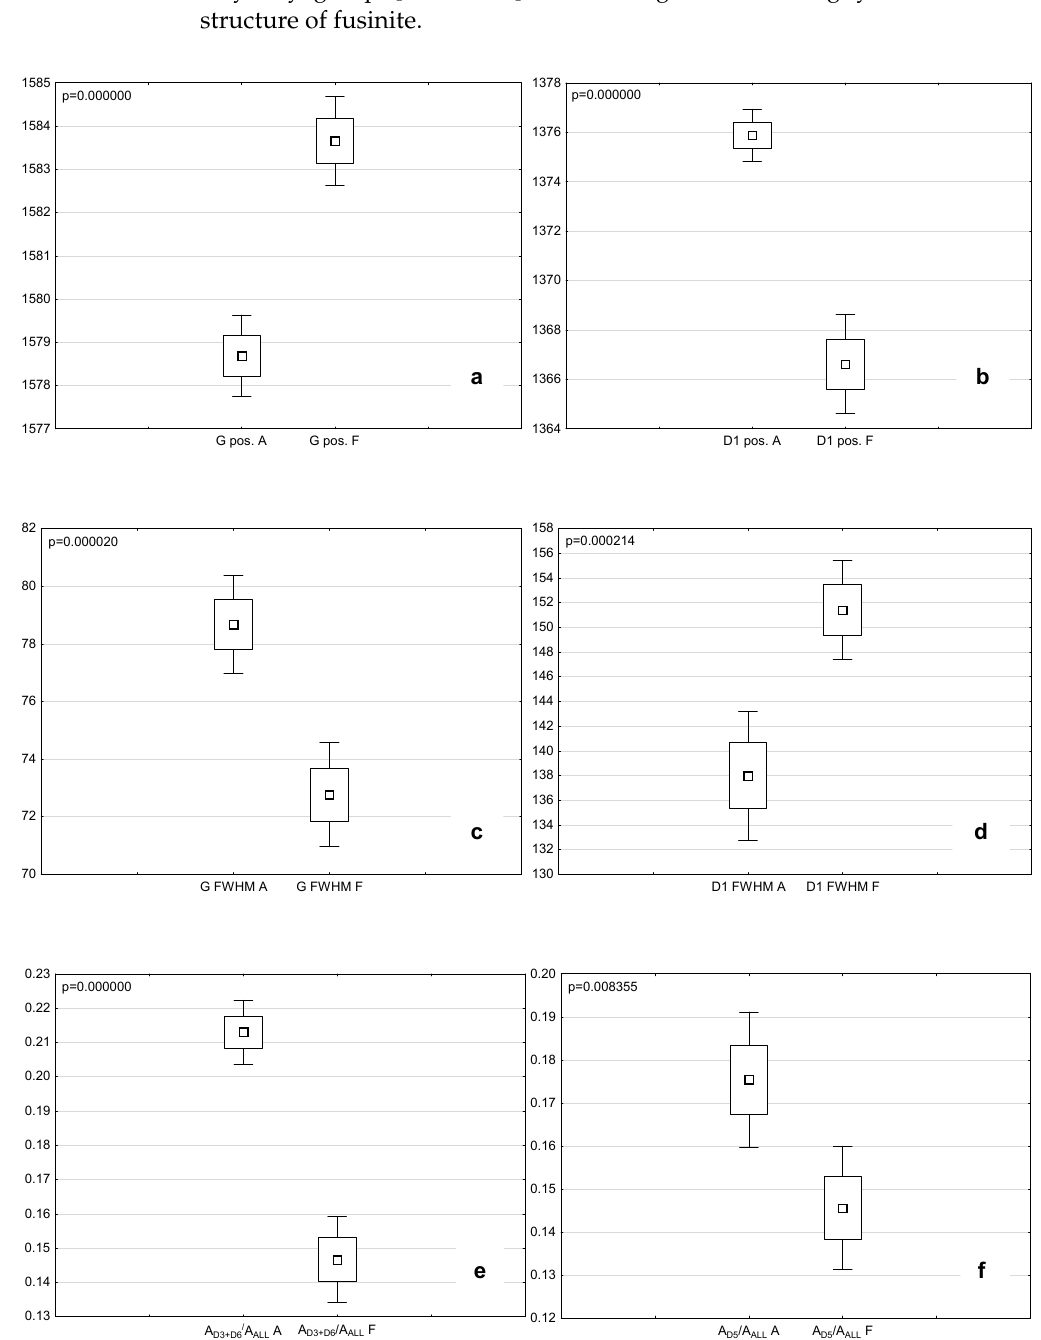
Figure 6. Comparison of Raman spectral parameters obtained for attrinite and fusinite: G band position ( a ), the D1 band position ( b ), the G band FWHM ( c ), the D1 band FWHM ( d ), the A D3+D6 /A ALL ratio ( e ), and the A D5 /A ALL ratio ( f ). Explanation: pos.—position; A—attrinite; F—fusinite.